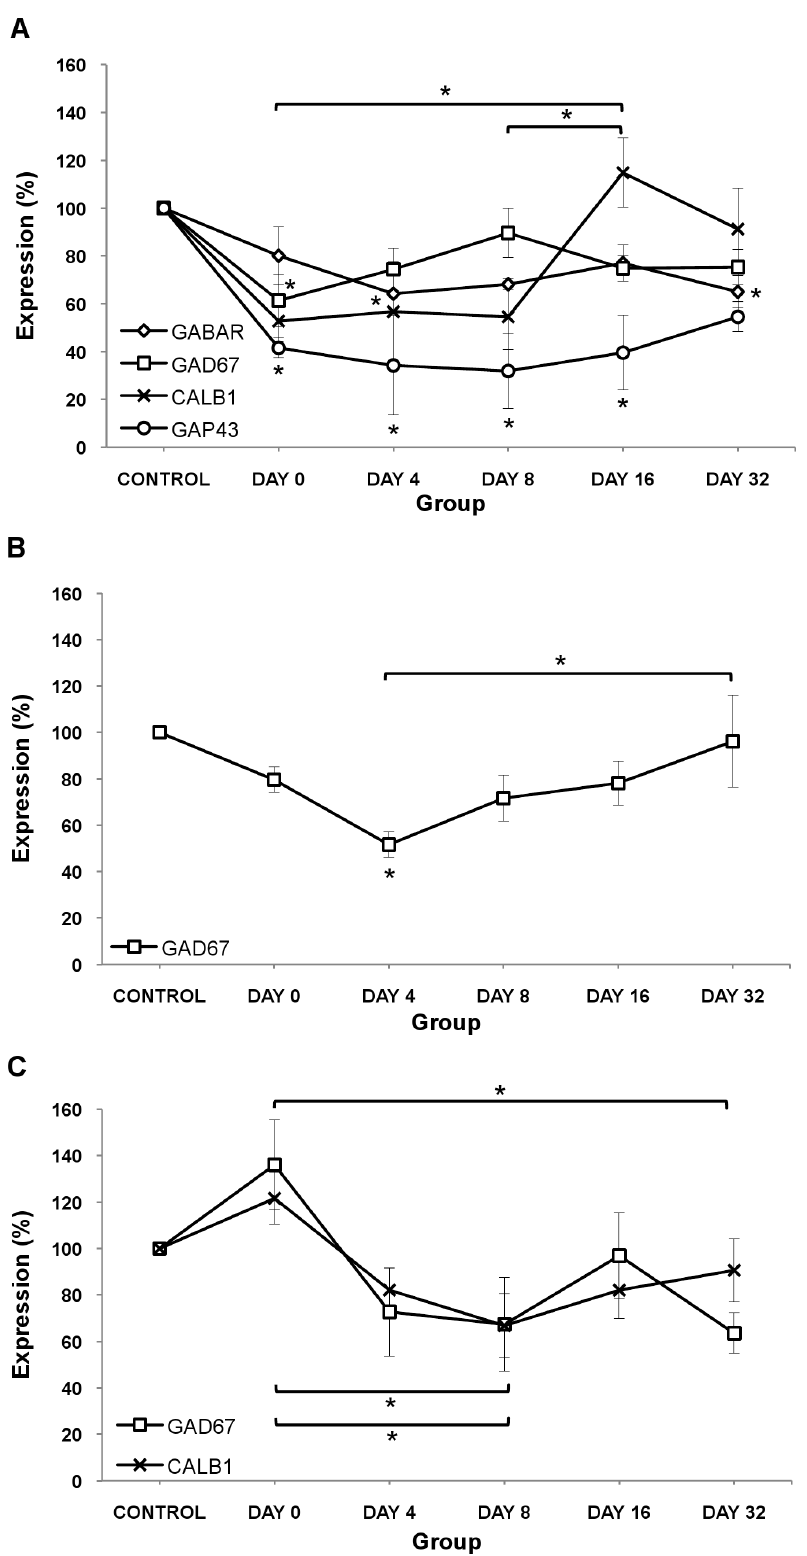
Figure 4. Expression of proteins of interest after acoustic trauma in Non-dominant Auditory Pathway. (A) Ipsilateral AC; (B) Ipsilateral IC and (C) Contralateral DCN. Results presented are the mean 6 SEM of density units expressed as a % compared to controls. NOTE: only protein expression that reached statistical significance are plotted on the graphs. * p , 0.05.